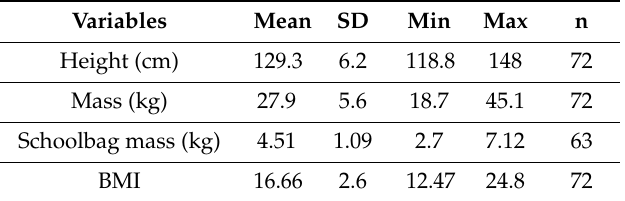
Table 1. Basic anthropometric